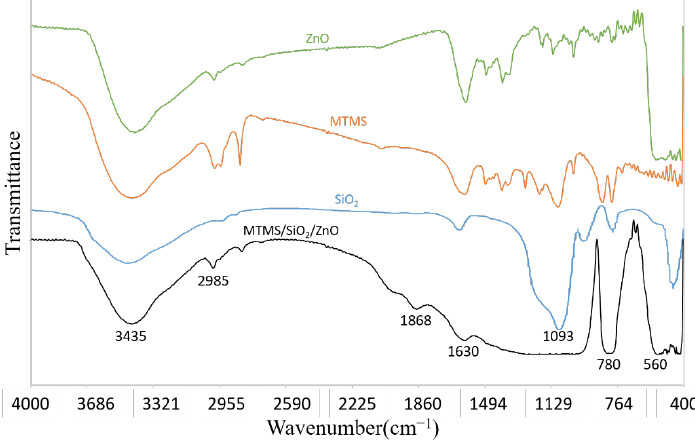
Figure 7. FTIR spectra of MTMS, SiO 2 , ZnO, and MTMS/SiO 2 /ZnO coating.